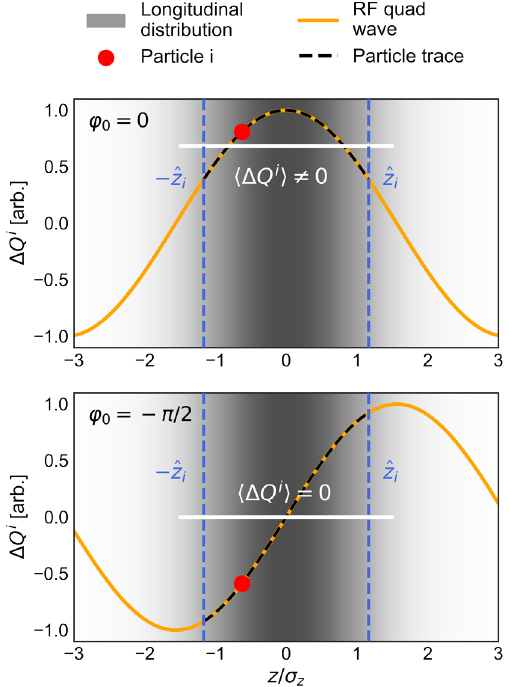
FIG. 3. Illustration of the detuning that a particle (red) expe- riences as it passes through an rf quadrupole (orange) turn after turn. Given enough time, the longitudinal position of the particle will be evenly distributed over the interval ½ − ˆ z i ; ˆ z i (cid:2) due to the synchrotron motion. It will hence experience a changing detuning every time it passes through (black dashed curve). If the rf quadrupole phase is φ 0 ¼ 0 (top), the average detuning will not vanish and there is a net incoherent tune spread. If φ 0 ¼ − π = 2 there will be no effective tune